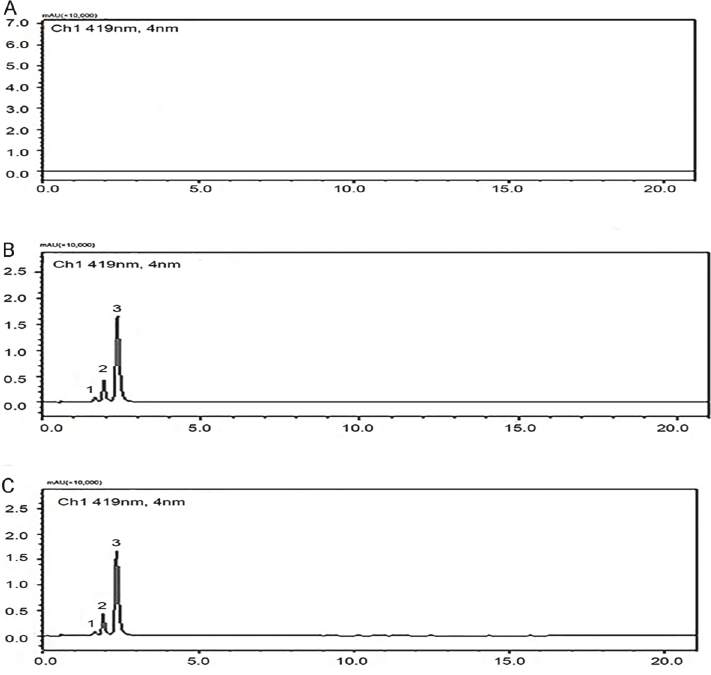
Figure 1. Speci fi city test results of blank intesti- nal perfusion fl uid ( A ), reference sample solution ( B ) and drug containing perfusion fl uid ( C ). 1: bisdemethoxycurcumin (BDMCur); 2: demethoxy- curcumin (DMCur); 3: curcumin